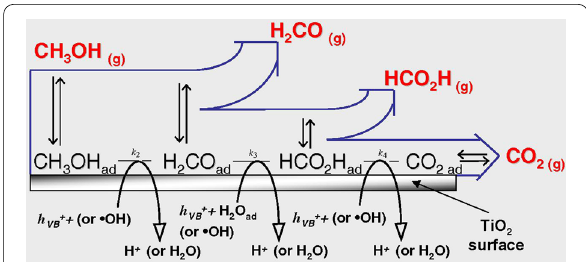
Fig. 9 The photoreformation mechanism of methanol over TiO 2 semiconducting material, featuring adsorption and desorption events and chemical transformations into formaldehyde, formic acid, CO 2, and H 2 . Reprinted with the permission from Chiarello et al. [86] (Copyright 2011